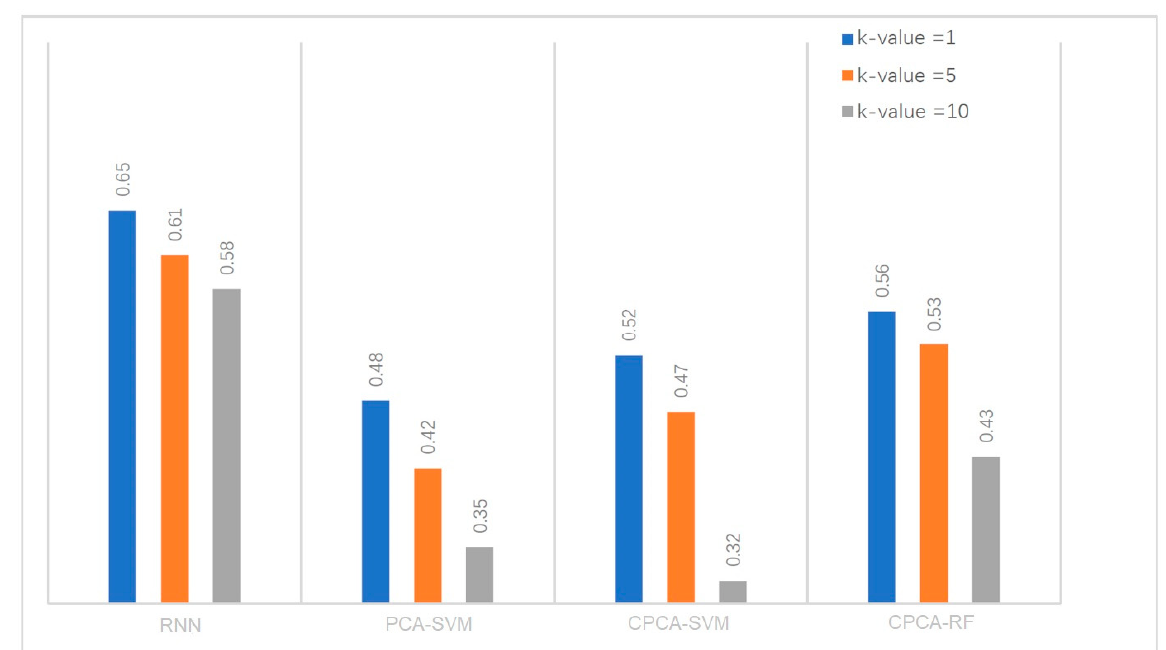
Figure 7. Comparison of the accuracy of K-nearest neighbor classification based on different feature extraction methods.